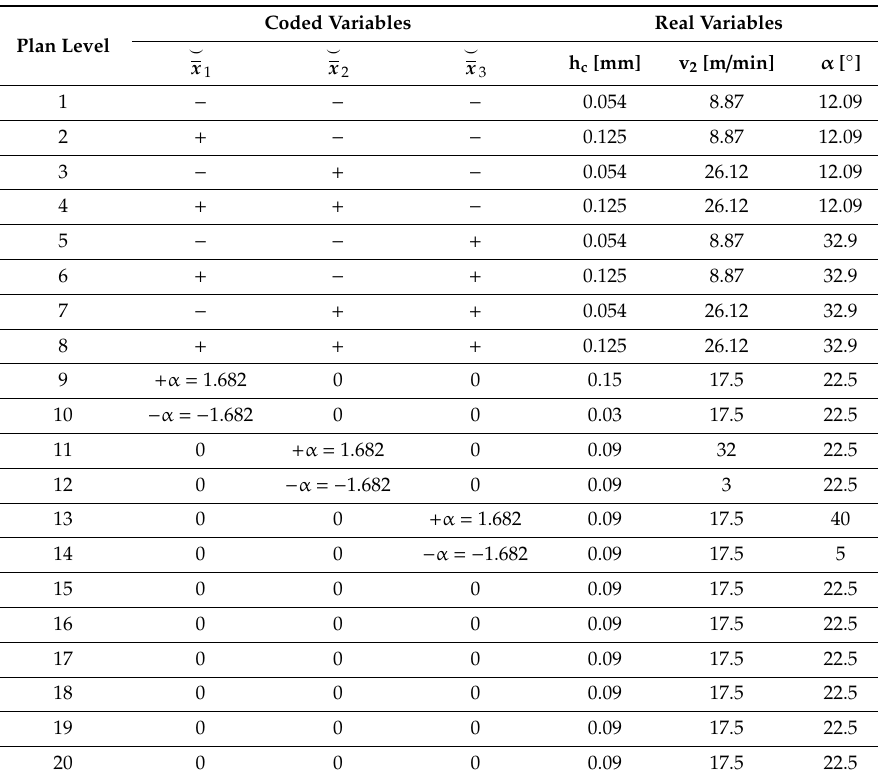
Table 4. Five-level rotatable plan of